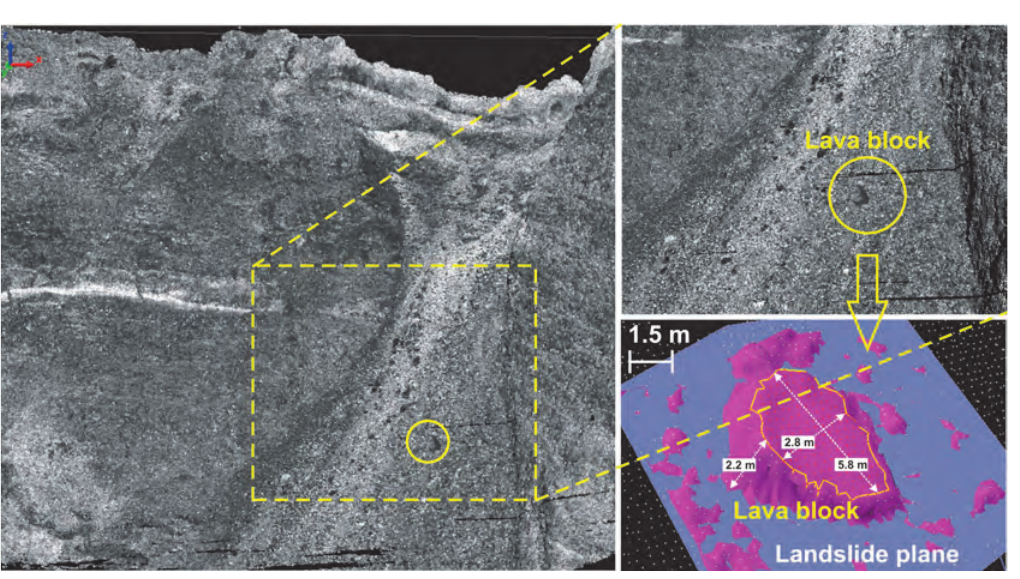
Fig. 13. Point cloud of the C-zone (landslide in volcanic environment, see fig. 6). The detail of a slide lava block and the size of the modeled surface are